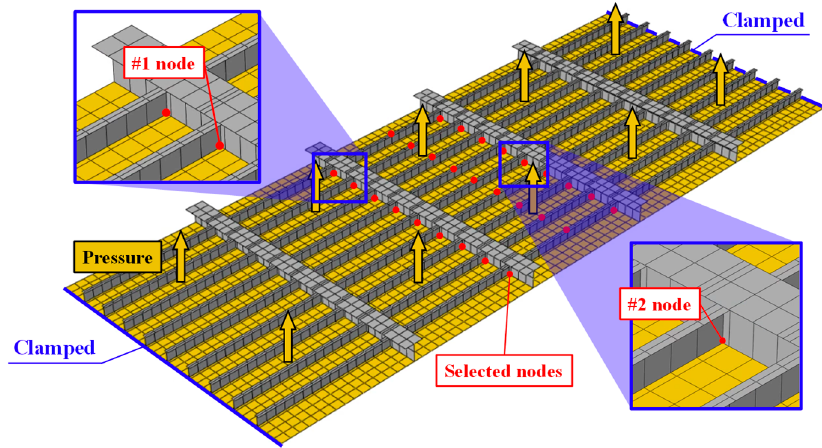
Figure 9. Stiffened plate with pressure applied to bottom and retained nodes.